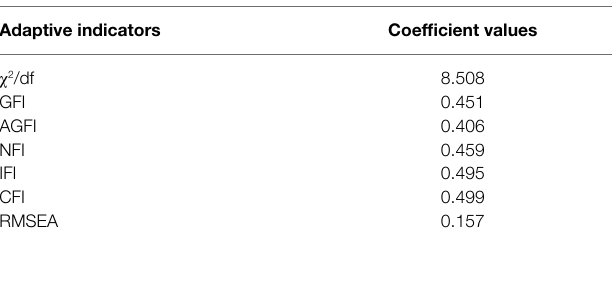
TABLE 3 | Adaptive indicators of the first-order confirmatory factor model. Adaptive indicators